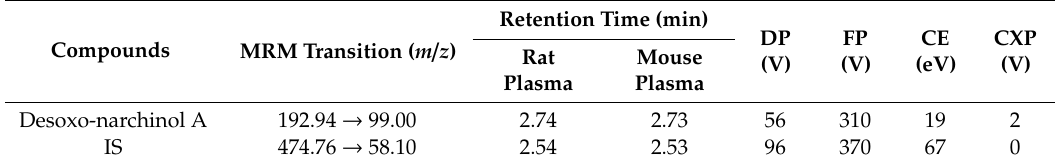
Table 1. Observed MRM transitions and mass spectrometry settings.